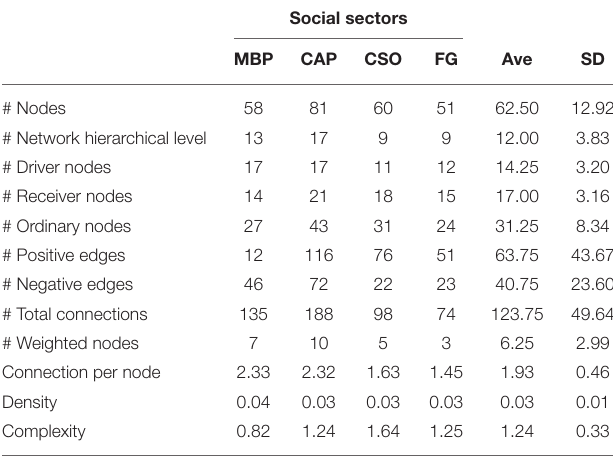
TABLE 2 | Summary of metrics and structure statistics for each one of the four sector’s networks. Average (Ave) and standard deviation (SD) for the metrics. Social